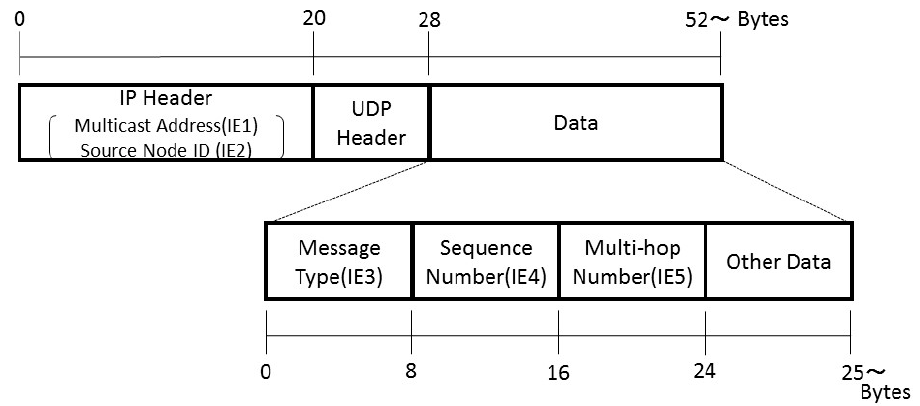
Figure 12. Packet format used by the stray node detection application.